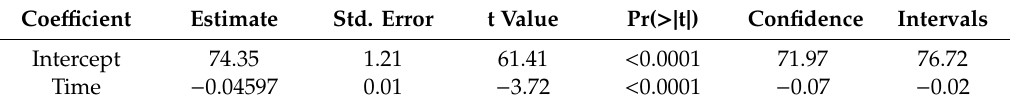
Table 7. Linear regression model of the variable Vickers hardness over time.